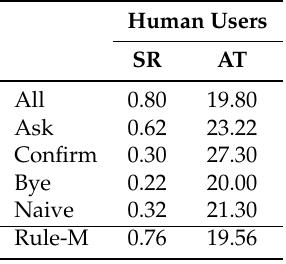
Figure 3. Training curves for different adjacency pairs settings. Table 4. Human users evaluation on Success Rate (SR) and Average Turns